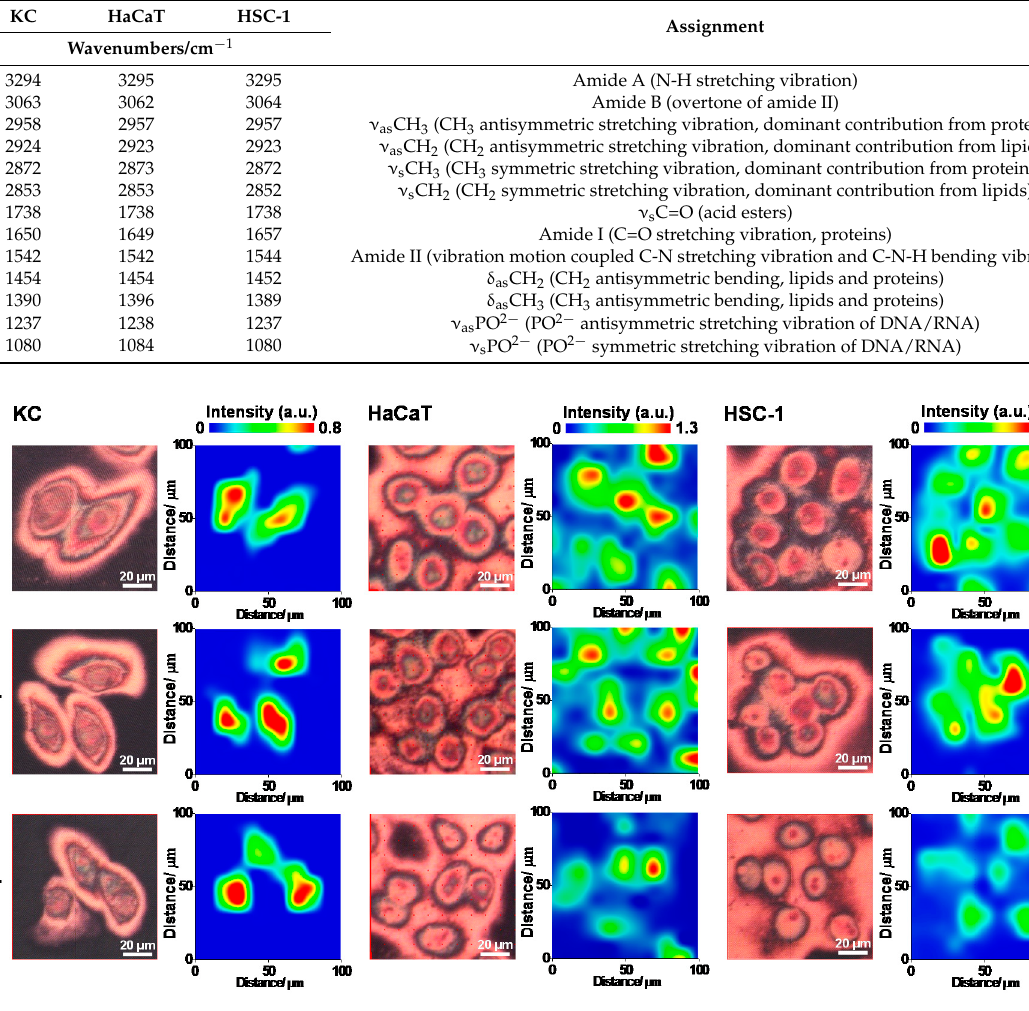
Figure 2. Peak height images of amide A band for KC, HaCaT and HSC-1 cell samples in the field of view of 100 × 100 µm 2 were presented after treating with sodium arsenite using SR-FTIR microspectroscopy. The FTIR images of peak height of amide A were collected at 3294 cm − 1 for cell samples (representative data were shown; 3 repeated experiments, 3 replicates, at least 10 cells were measured). Table 1. Peak assignment of FTIR spectra of skin cell samples.